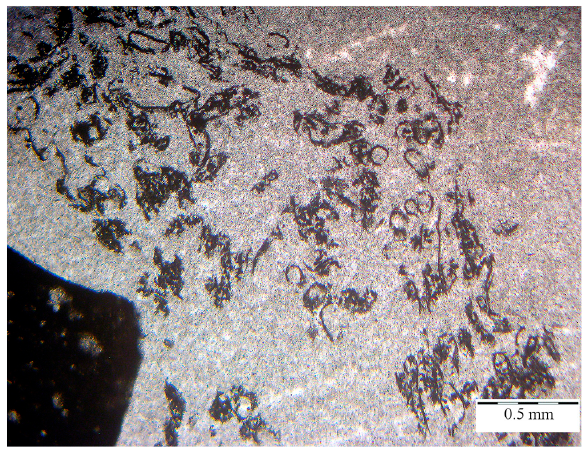
Figure 5. Microphotograph of organic detritus in resin variety II, polarized light; 1 N.